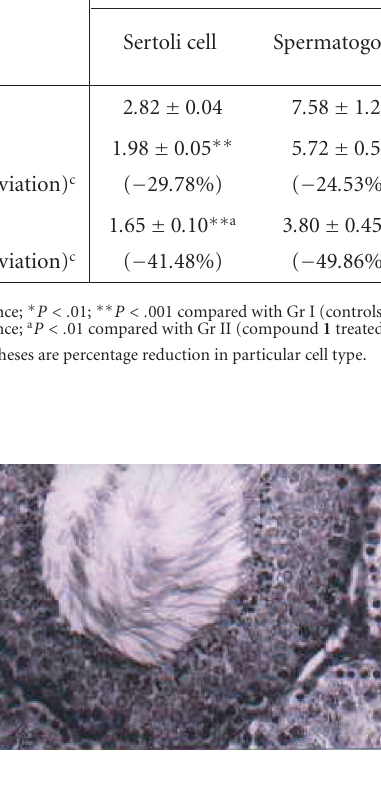
Figure 1: Microphotograph of testis of control rat showing all the successive stages of spermatogenesis. Lumen containing spermato- zoa. X 200 HE.